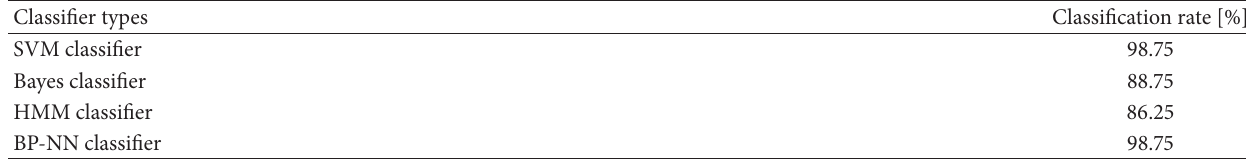
Table 7: Comparison for classification results using different classifiers.